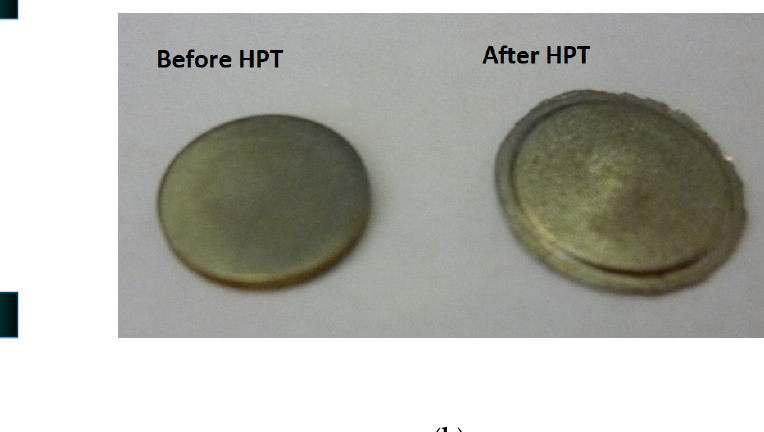
Figure 1. ( a ) Principle of HPT processing [47], ( b ) disc samples before and after HPT processing. Reprinted with permission from ref. [47]. Copyright 2022 Elsevier.